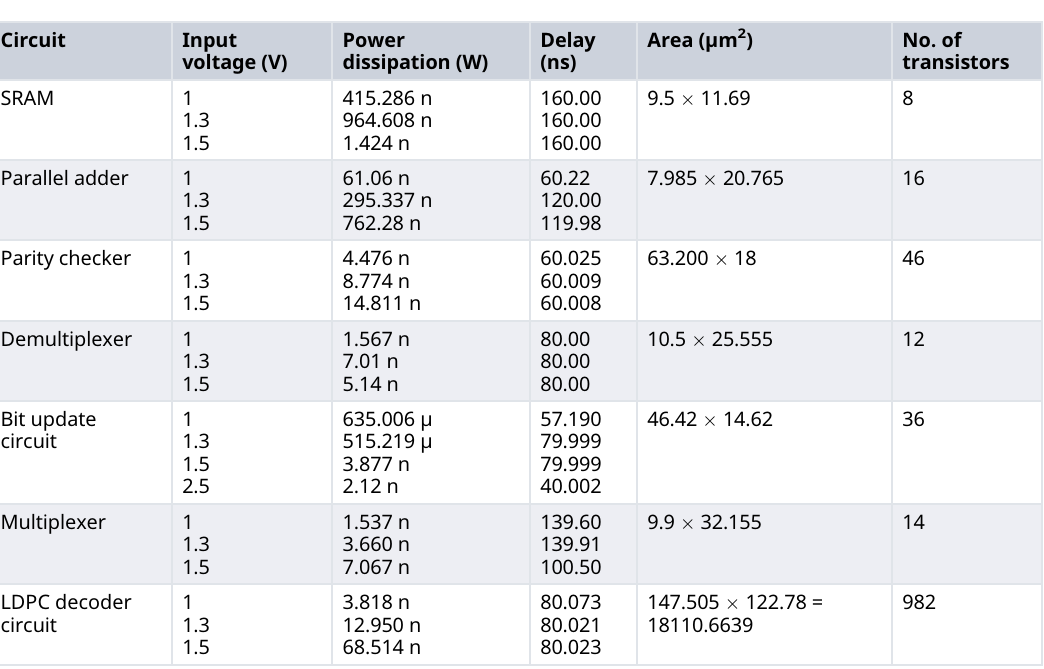
Table 3. Results of the proposed LDPC decoder circuits